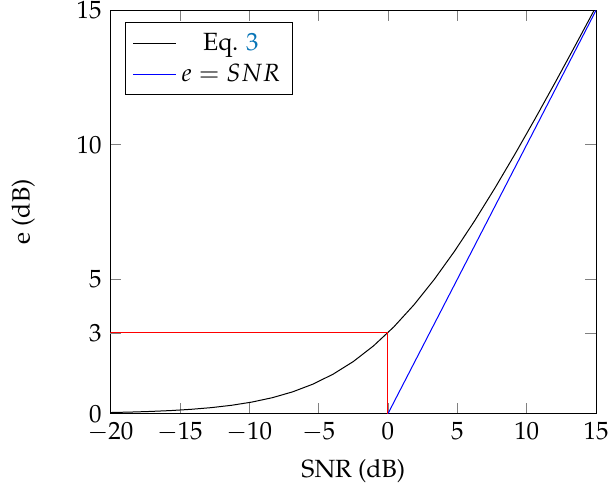
Figure 2. Relationship between signal-to-noise ratio (SNR) and e